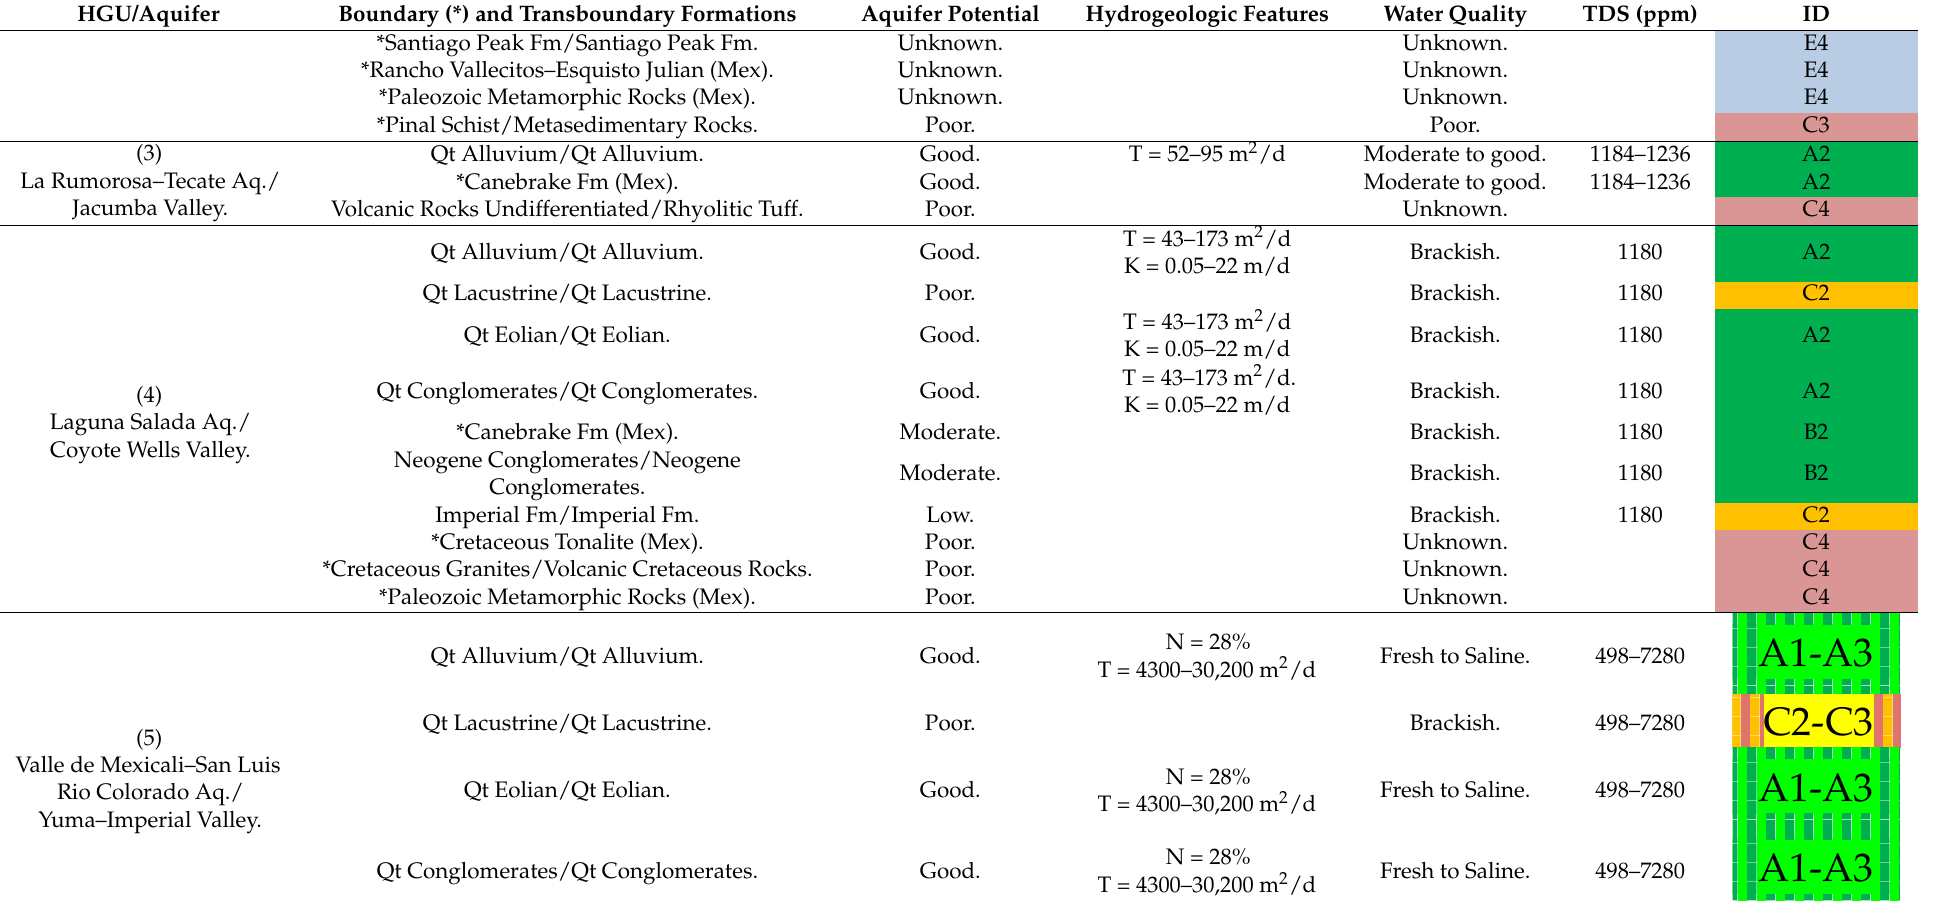
Table 3. Classification of geological formations (within their corresponding HGU) in the border region between